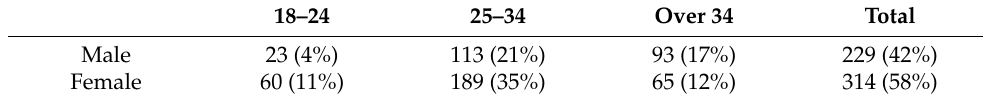
Table 1. Age and gender characteristics of the samples in China.